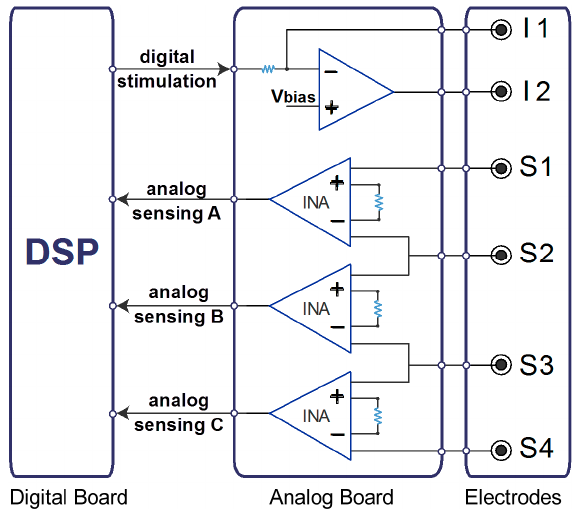
Figure 1. Scheme of our BIS system consisting of a digital board ( left ) with a DSP that generates the periodic stimulation waveforms and receives three sensed voltages for Fourier analysis; an analog board ( middle ) with a transconductance amplifier to produce the stimulation current and three instrumentation amplifiers for reading voltage drops across body segments; and an electrode set-up ( right ) consisting of two injecting electrodes (I1, I2) and four sensing electrodes